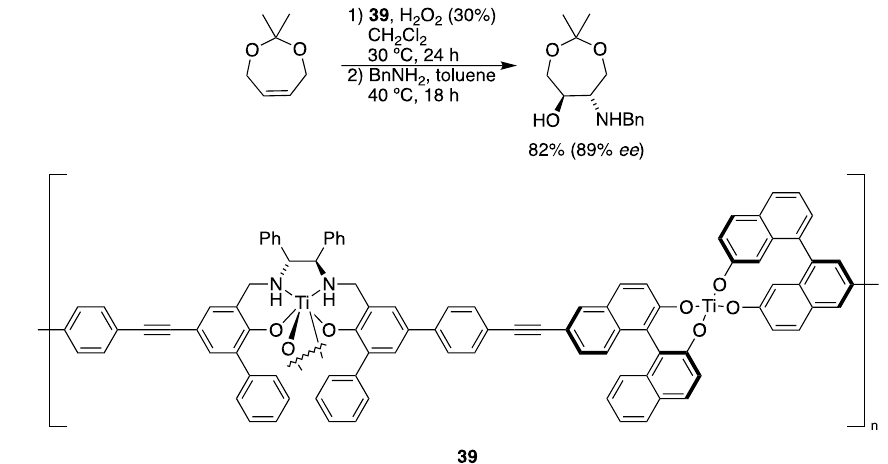
Figure 17. ( a ) A schematic representation of 2D titanium metal–organic coordination assemblies. ( b ) A self-supported chiral Ti–salen catalyst with different linkers and diamine substituents.